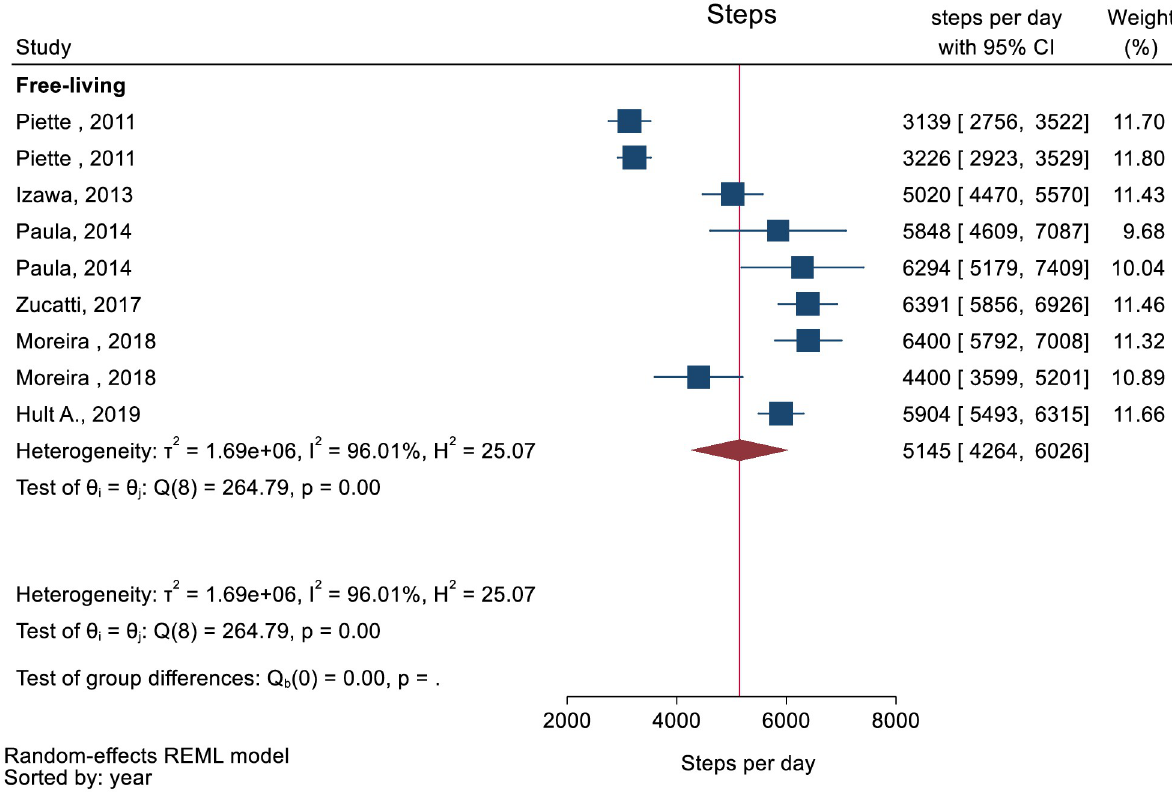
Fig 5. Forest plot showing daily number of steps in people with multimorbidity.